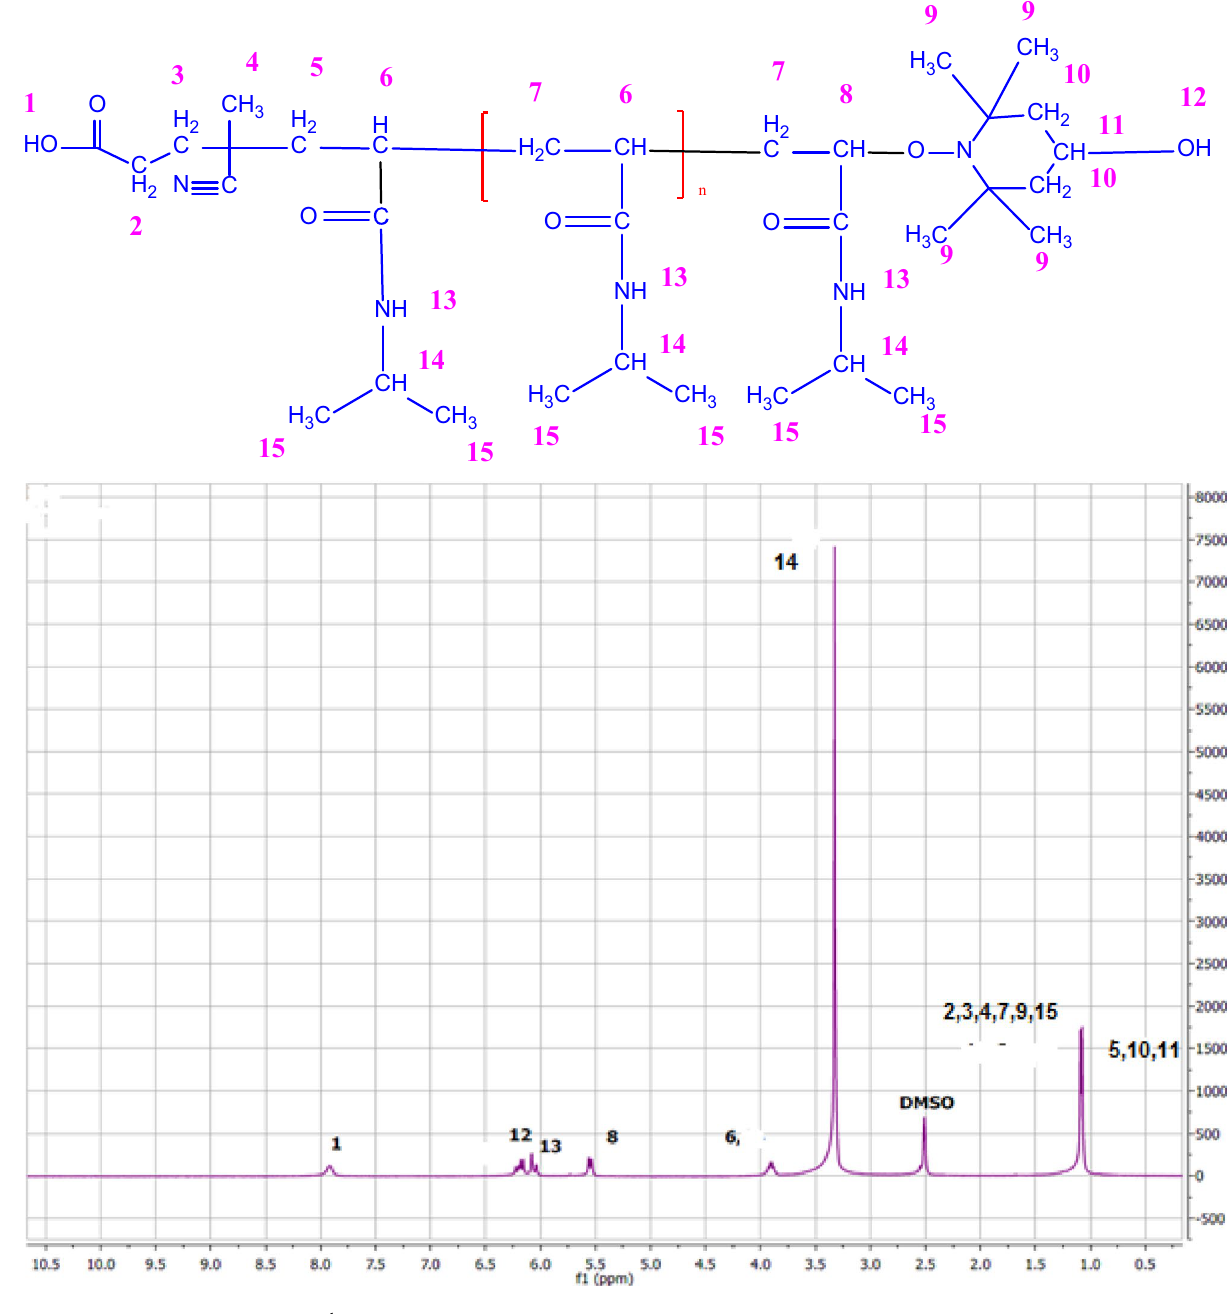
Figure 9. 1 HNMR diagram of difunctionalized